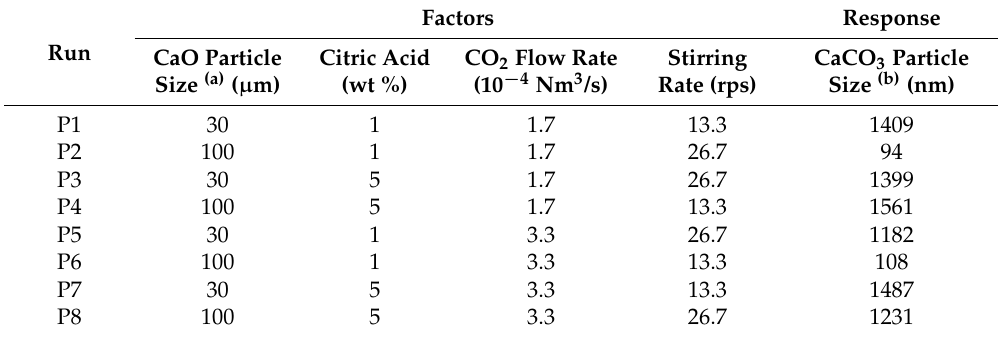
Table 1. Data set for the fractional factorial design of experiment (FFDoE). P1-8 are different preparation